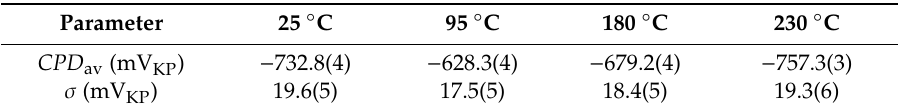
Figure 8. Histograms of contact potential di ff erence ( CPD ) for maps shown in Figure 7; solid lines—fit of the Gaussian distribution; V KP is the voltage measured versus Kelvin probe. Table 3. Statistical parameters for the contact potential di ff erence ( CPD ) maps of the AISI 1010 steel electrodes immersed in sulfolane at 25, 95, 180, and 230 ◦ C; CPD av is the average value and σ is the standard deviation; V KP is the voltage measured versus Kelvin